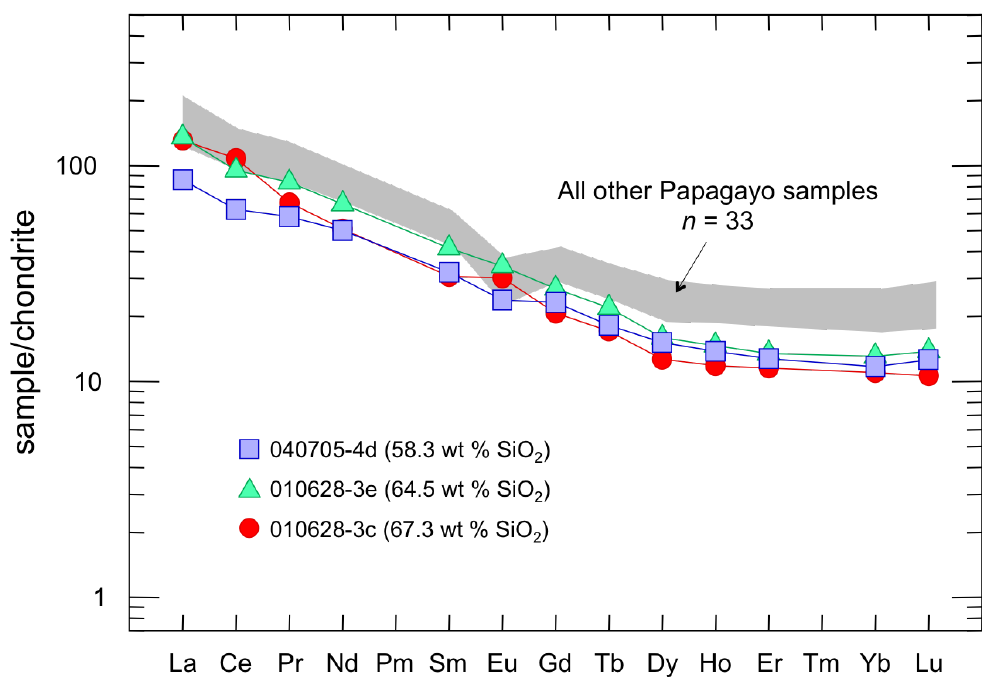
Figure 5. Chondrite-normalized rare earth element (REE) plot showing the range for Papagayo samples ( n = 33) and the three “anomalous” samples.